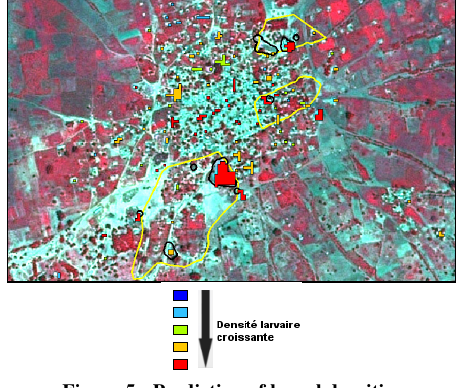
Figure 5 : Prediction of larval densities